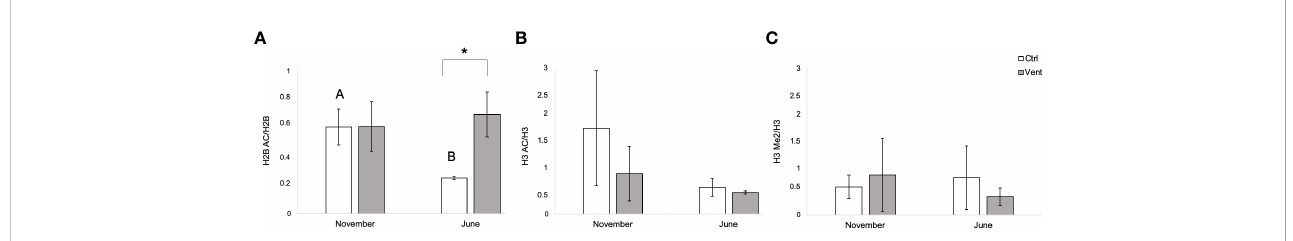
FIGURE 2 Ratio of histone modi fi cations H2BK16Ac/H2B (A) , H3K27Ac/H3 (B) and H3K4Me2/H3 (C) measured through western blotting in in Platynereis spp. collected in November and in June at the non-acidi fi ed control site and in the CO 2 vents of Castello Aragonese. Different letter means statistically signi fi cant differences among polychaetes from the two sites (p ≤ 0.05). The asterisk (*) means statistically difference among polychaetes from the same site at different collecting periods.